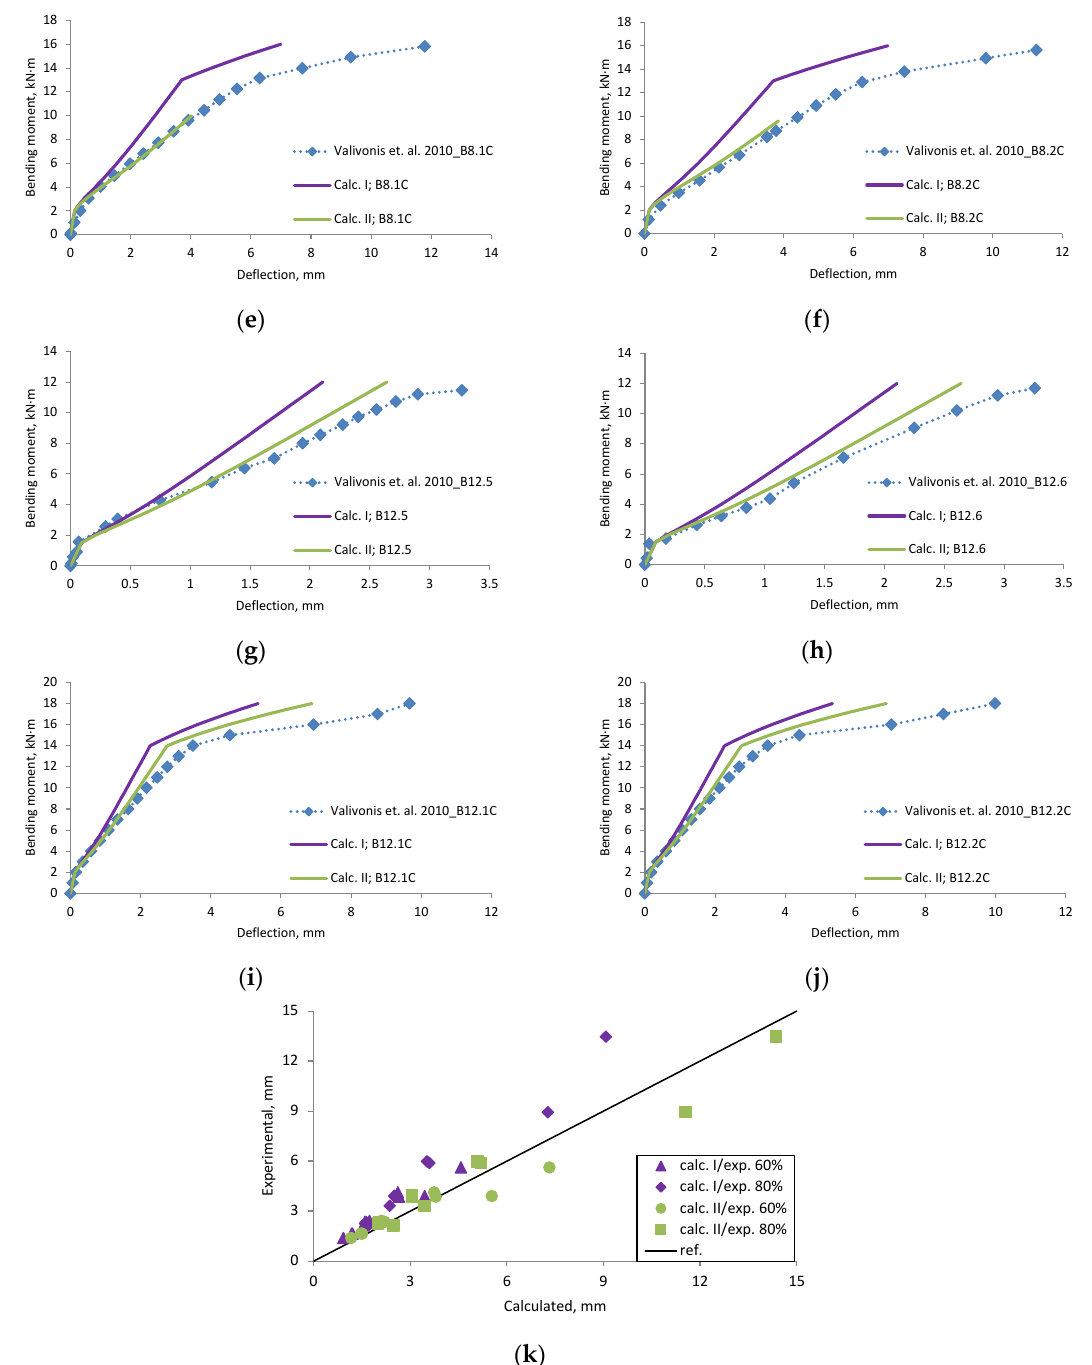
Figure A20. Valivonis et al., 2010 [14] research beams deflection compared with calculated, ( a ) beam B6.5; ( b ) beam B6.1C; ( c ) beam B6.2C; ( d ) beam B8.3; ( e ) beam B8.1C; ( f ) beam B8.2C; ( g ) beam B12.5; ( h ) beam B12.6; ( i ) beam B12.1C; ( j ) beam B12.2C; ( k ) scatter of the results at 60% and 80% of the ultimate load.